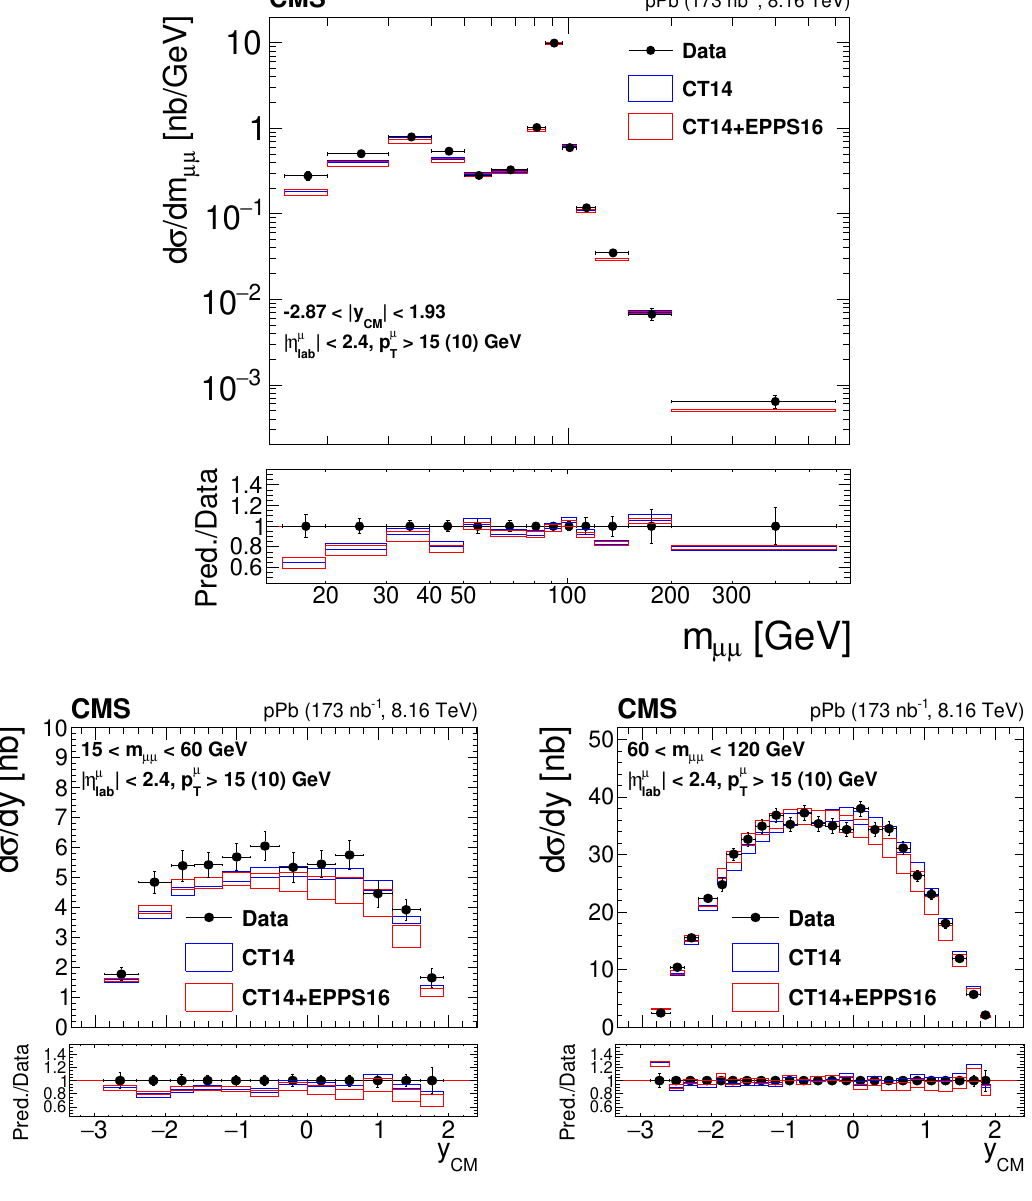
Figure 5 . Differential fiducial cross section (without the acceptance correction) for the DY process measured in the muon channel, as a function of the dimuon invariant mass (upper) and rapidity in the centre-of-mass frame for 15 < m < 60 GeV (lower left) and 60 < m < 120 GeV (lower right). mm mm The error bars on the data represent the quadratic sum of the statistical and systematic uncertain- ties. Theory predictions from the powheg NLO generator are also shown, using CT14 (blue) or CT14+EPPS16 (red). The boxes show the 68% confidence level (n)PDF uncertainty on these predic- tions. The ratios of predictions over data are shown in the lower panels, where the data and (n)PDF uncertainties are shown separately, as error bars around one and as coloured boxes,